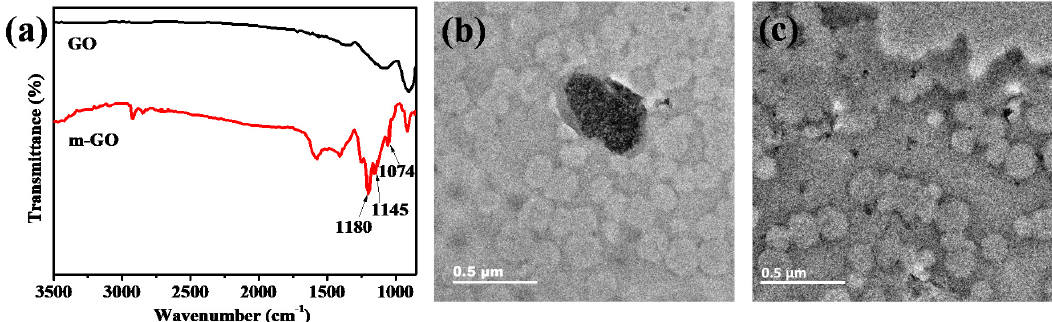
Figure 4. ( a ) FT-IR spectra of GO and m-GO. ( b ) TEM of FEVE/GO. ( c ) TEM of